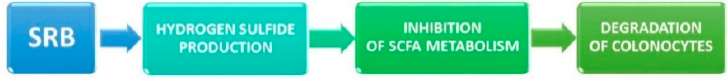
Figure 5. Mechanism of H 2 S toxicity. SRB: Sulfate-Reducing Bacteria.